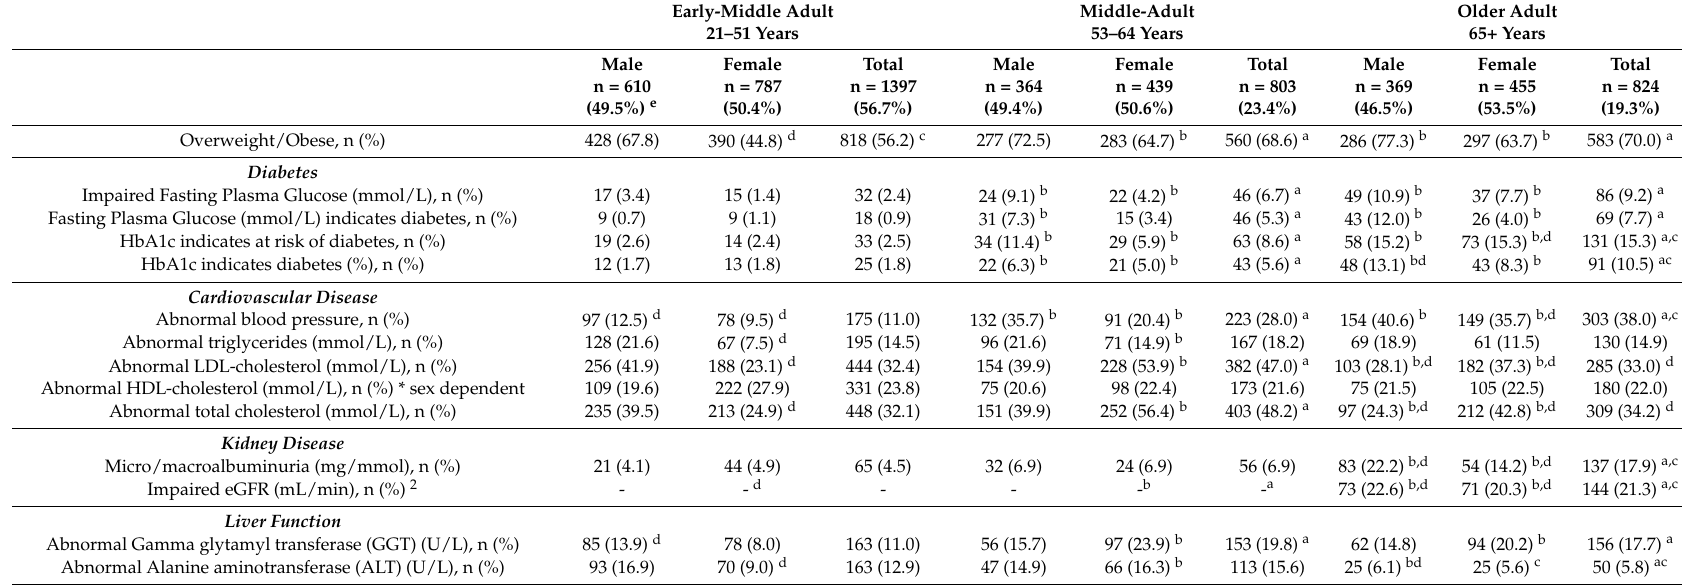
Table 3. Biomedical risk factors of early-middle adults (21–51 years, n = 1397), middle-adults (52–63 years, n = 803) and older adults (65+ years, n = 824) in Australia.